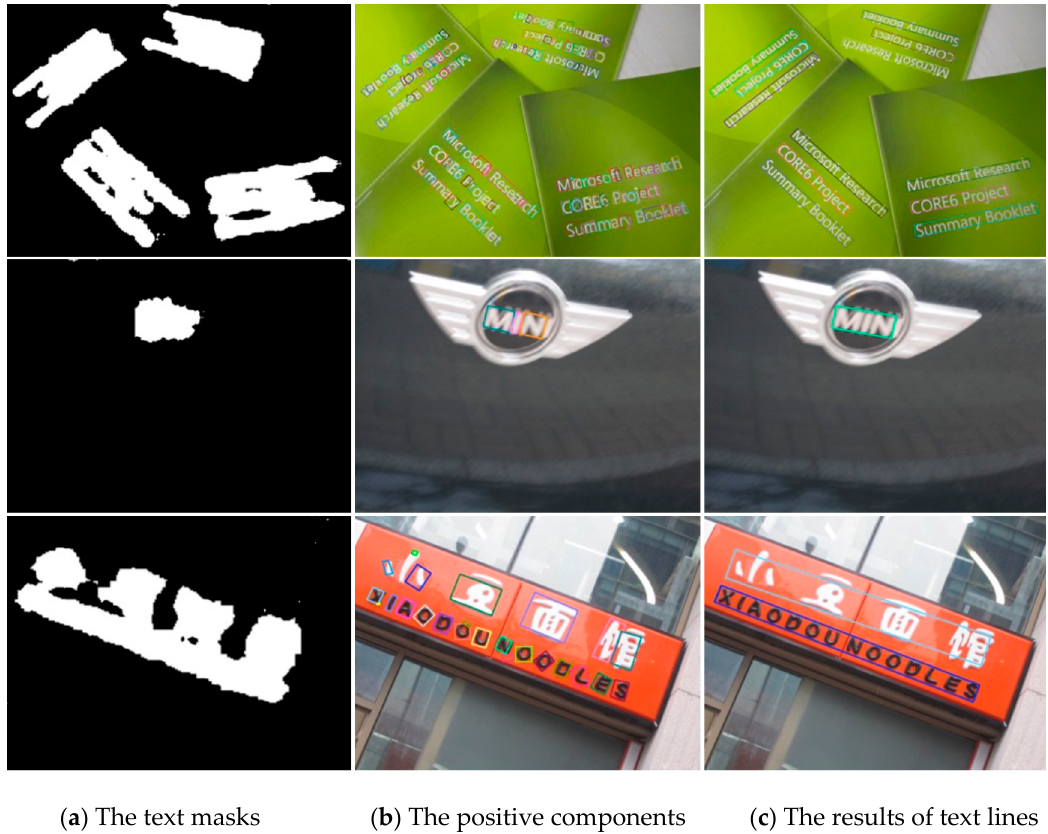
Figure 8. The results of text detection on some challenging images. ( a ) Dense text masks. ( b ) Positive text components are successfully distinguished with the text masks. ( c ) The final text lines are constructed directly with our assembling algorithm.